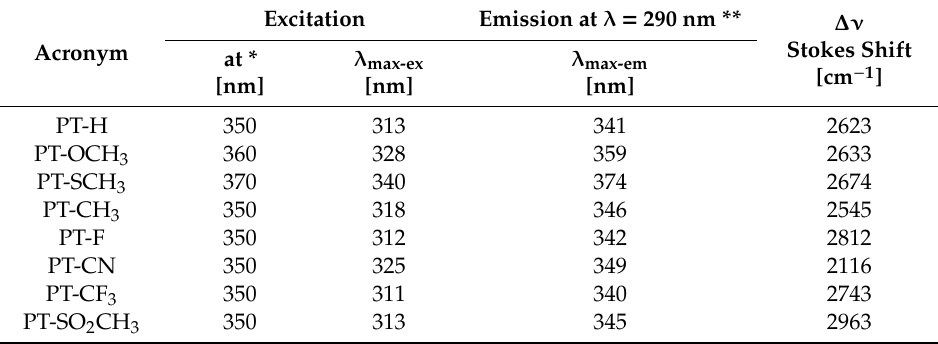
Figure 3. ( a ) Normalized excitation spectra of the 2,6-diphenylpyridine derivatives in acetonitrile; ( b ) Normalized emission spectra of the 2,6-diphenylpyridine derivatives in acetonitrile; λ ex = 290 nm is the excitation wavelength, used to obtain emission spectra. Table 2. Spectral characteristics of the 2,6-diphenylpyridine derivatives in acetonitrile.